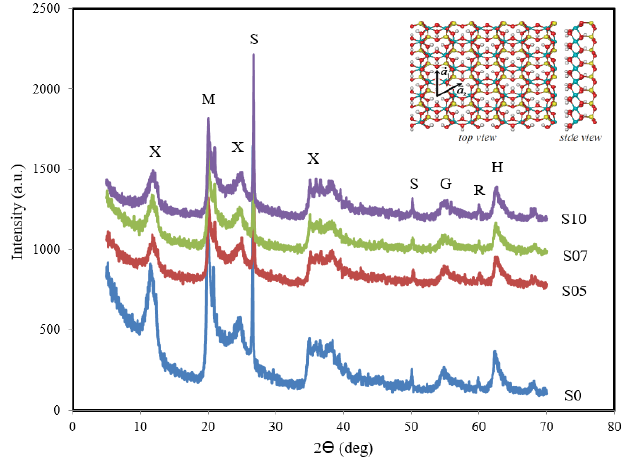
Figure 1. XRD patterns of S0, S05, S07, and S10. X, halloysite (7 Å); M, sodium aluminum silicon oxide; S, quartz; R, silicon oxide; G, graphite.